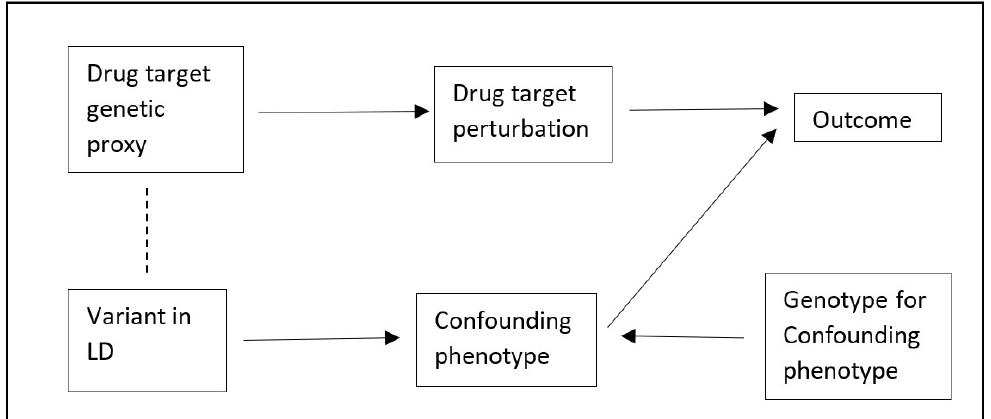
Figure 1. Directed Acyclic Graph (DAG) representing confounding by linkage disequilibrium in a cis -Mendelian randomisation analysis.